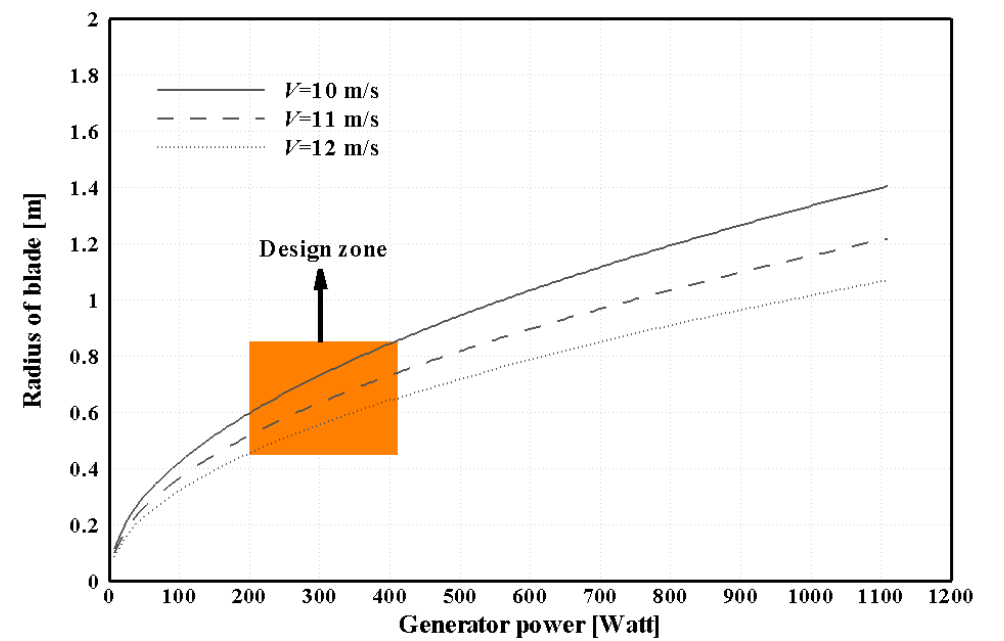
Figure 6. Distributions of the blade radius with the generator power at the wind speed of 10 m/s, 11 m/s and 12